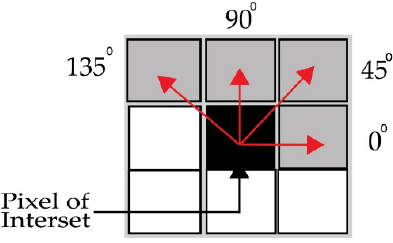
Figure 5. Illustration of grey level co-occurrence matrix (GLCM).